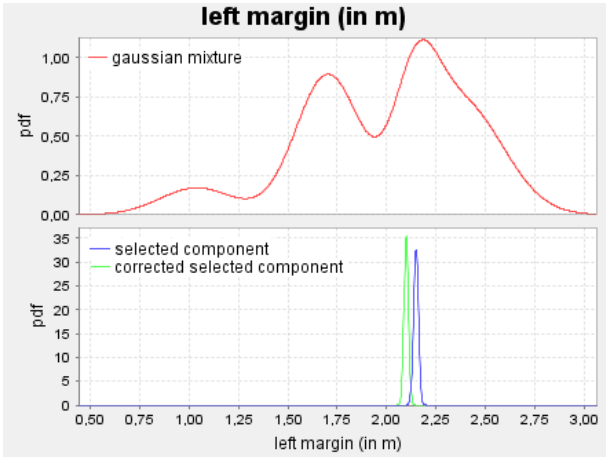
Figure 4: distributions for left margin: gaussian mixture as prior (top) and selected component for determining the posterior (bot-